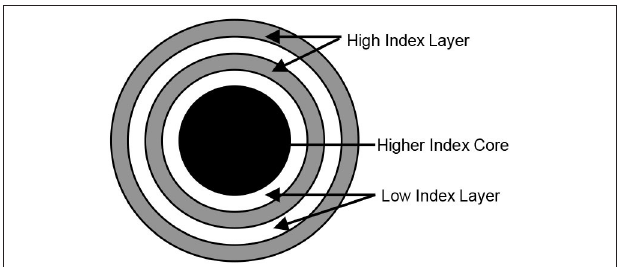
FIGURE 1 | Sectional drawing of Bragg fiber with high-index core.